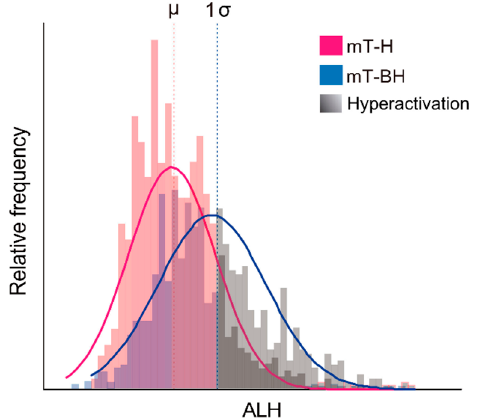
Figure 1. Example for the estimation of the percentage of hyperactivated spermatozoa in one individual of M. musculus . The relative frequency of values of amplitude of lateral head displacement (ALH) was plotted for spermatozoa, incubated under non-capacitating and capacitating conditions over time; see text for details. Non-capacitating conditions (mT-H medium): pink line and bars. Capacitating conditions (mT-BH medium): blue line and bars. Sperm in each condition are classified as hyperactivated when their ALH value surpasses the mean +1 standard deviation interval estimated from the control (non-capacitating) condition. Hyperactivated sperm are represented with different tones of grey. µ: ALH mean in non-capacitating conditions. 1 σ : 1 standard deviation.